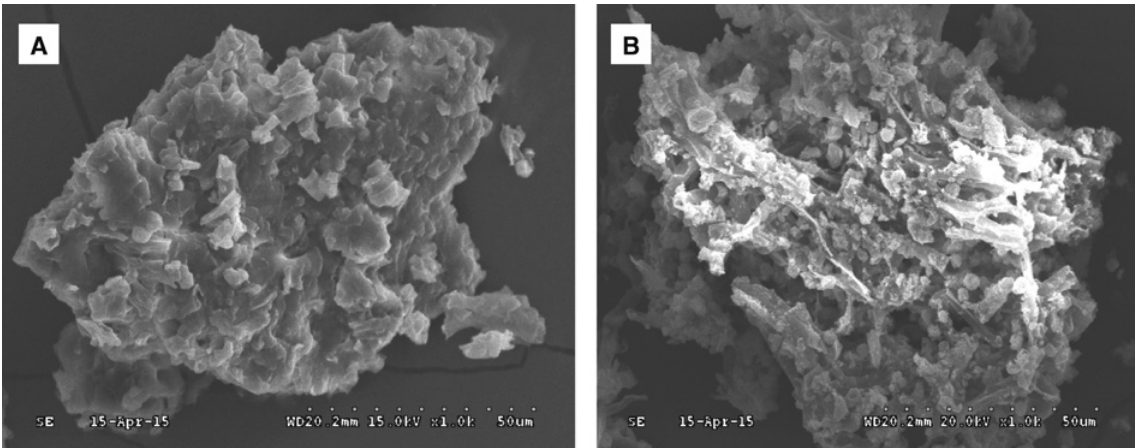
Figure 5: SEM of A. flavus (F3) biomass (A) before and (B) after bioleaching. Two-week-old cultures were grown on SDB medium, and then the fungal biomass was dried in an oven at 60 ° C and treated with 10% glutaraldehyde and incubated for approximately 10–12 h at 4 ° C. The pretreated specimen was then sputtered with gold particles using a sputter coater under vacuum and observed under SEM at an accelerating voltage of 12 or 15 kV to capture images.